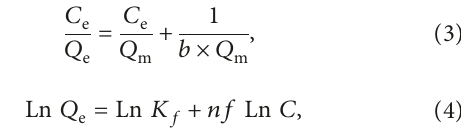
e with respect to